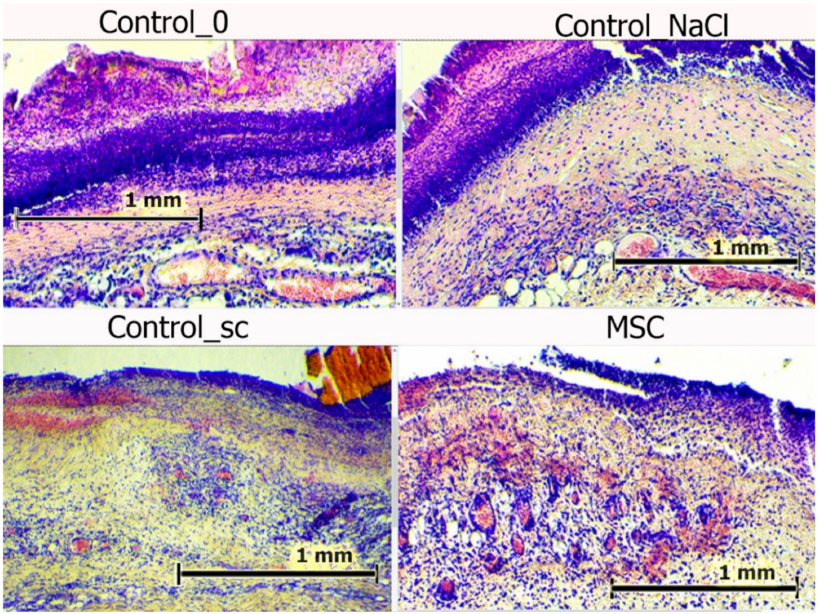
Figure 7. Wounds centers in different groups on day 3. Hematoxylin and eosin staining (100 × ). The scale bar is 1